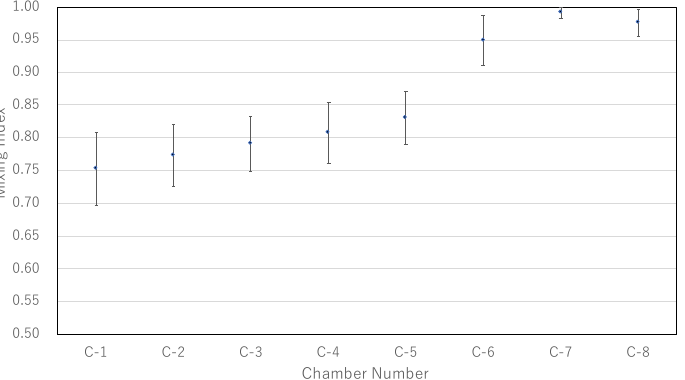
Figure 8. Graph of average of concentrations after 9 s for 9 experiments. Error bars represent standard error. The concentration gradient iwass generated roughly along the pressure